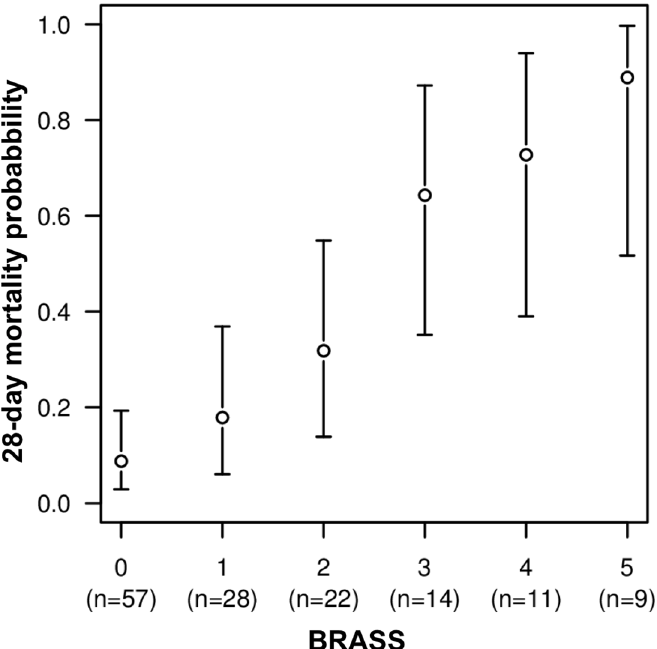
Fig 3. 28-day mortality probability according to the BRASS. Mortality probabilityexpressedin mean [95% CI], BRASS: Brainstem Responses Assessment Sedation Score.